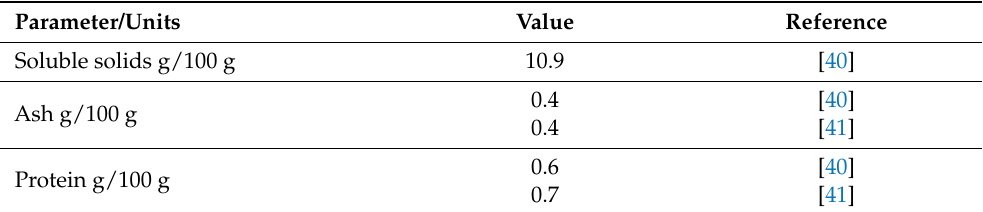
Table 1. Physical and bromatological parameters of the Vaccinium floribundum berry.